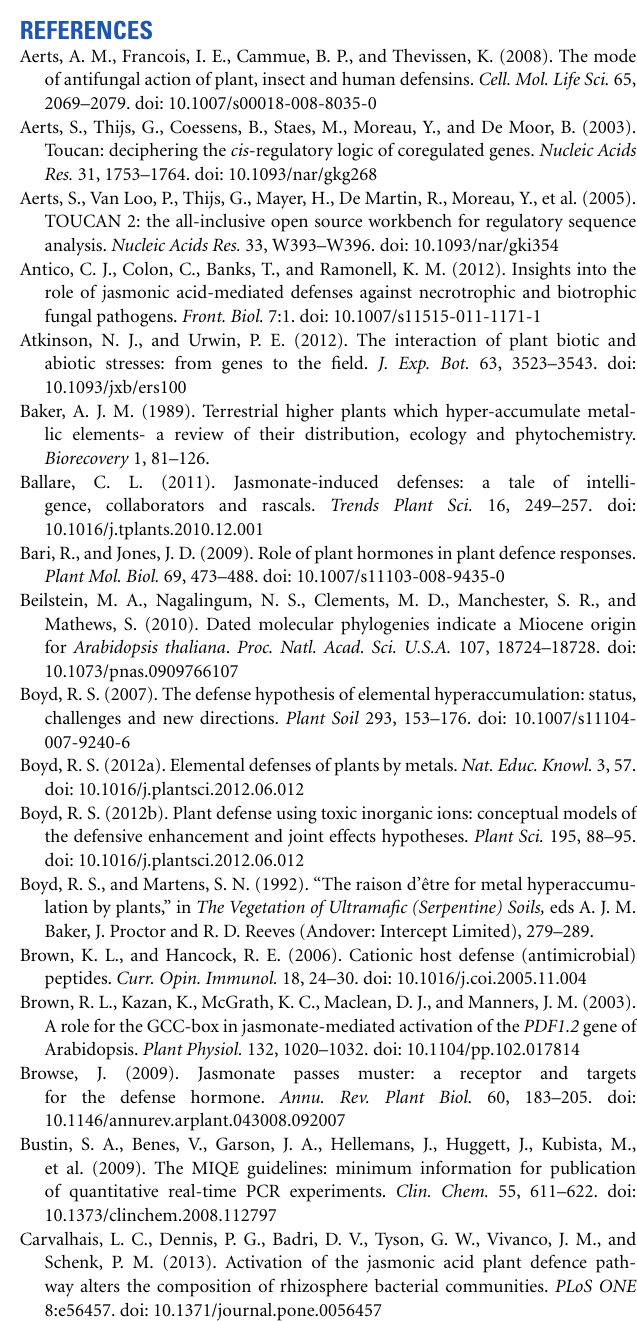
Supplementary Table 4 | Values from Kruskal Wallis tests comparing the PDF1 relative expression levels to actin determined for A. thaliana and A. halleri plants upon transfer to MeJA or ZnSO 4 .